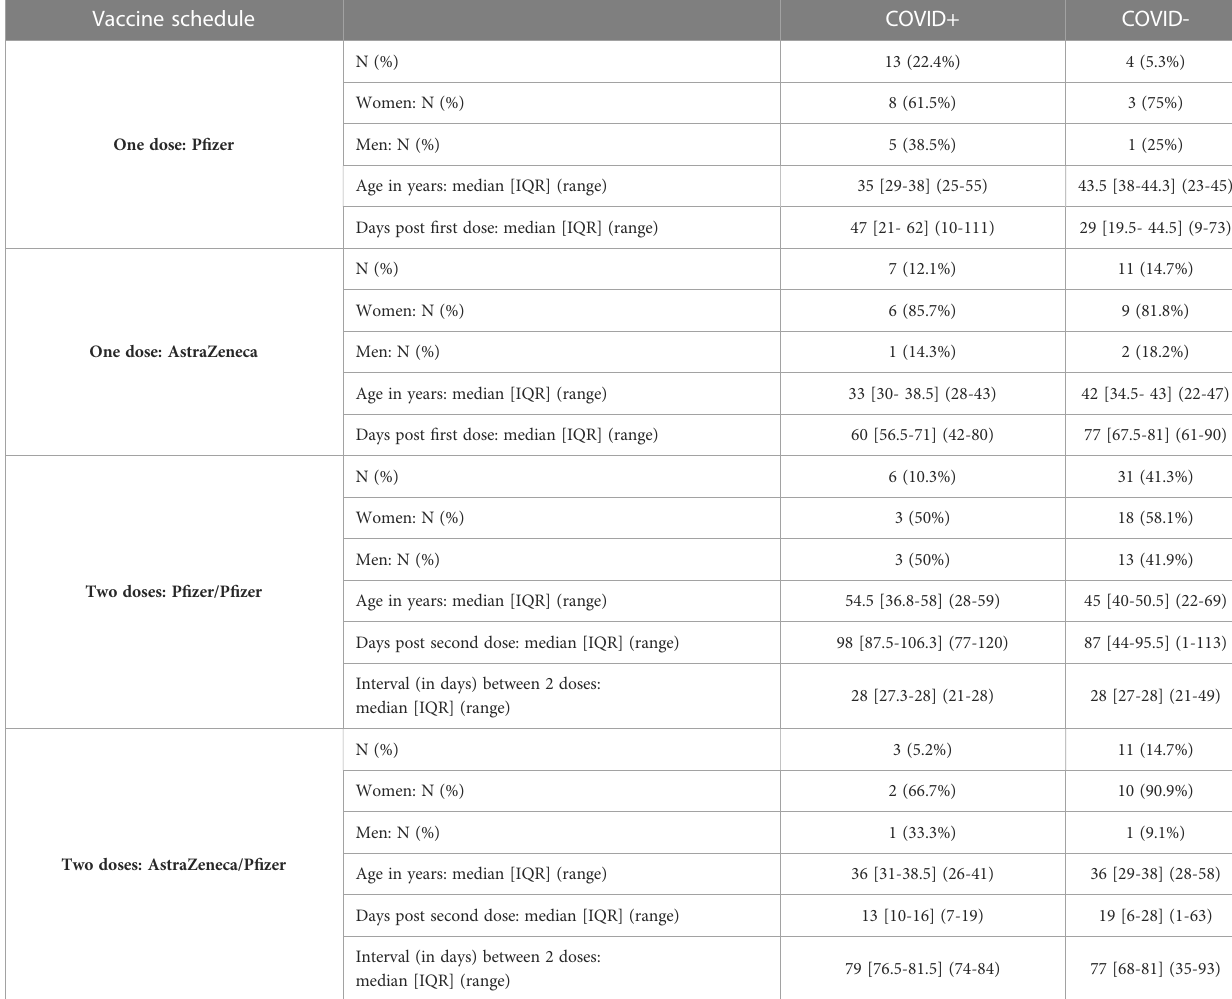
TABLE 3 Vaccine schedule of naive (COVID-) and previously infected individuals (COVID+) at the last visit (V3). Vaccine schedule COVID+